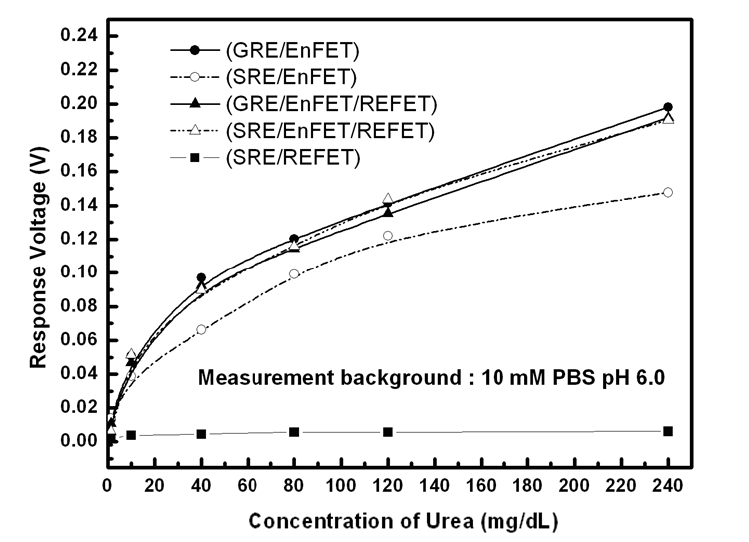
Figure 9. Urea response of test structures of the GRE/EnFET, SRE/EnFET, GRE/EnFET/REFET, QRE/EnFET/REFET and SRE/REFET dL in axis